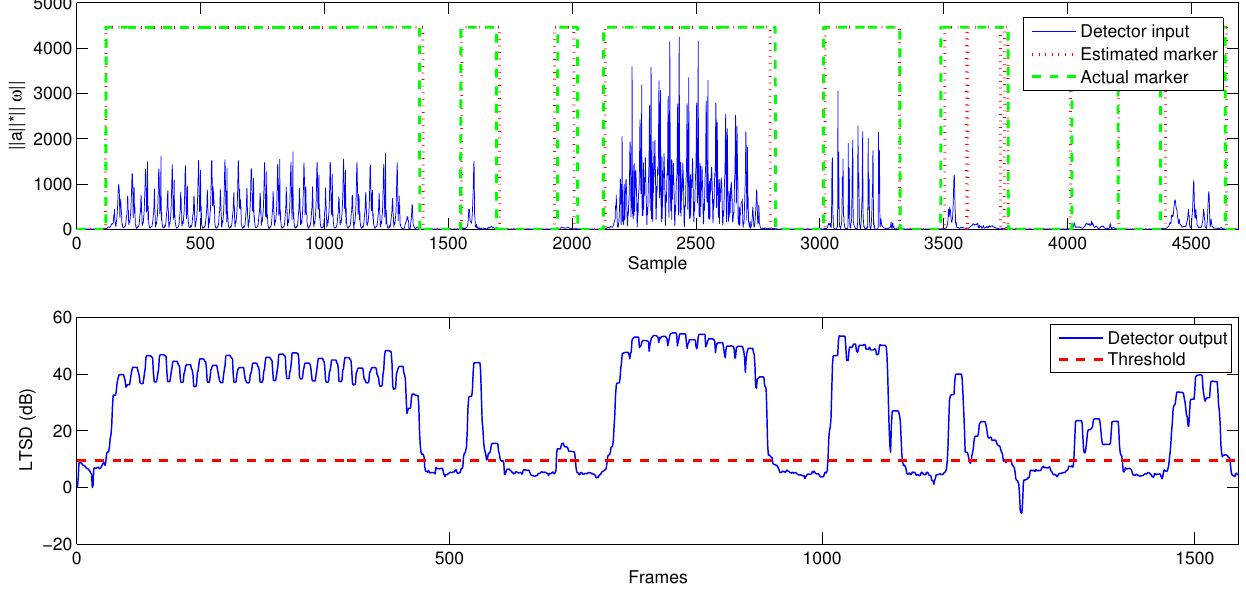
Figure 7. Input (product of acceleration and angular rate magnitude) and output (vector of characteristics and marker) of the LTSD. Real signals.